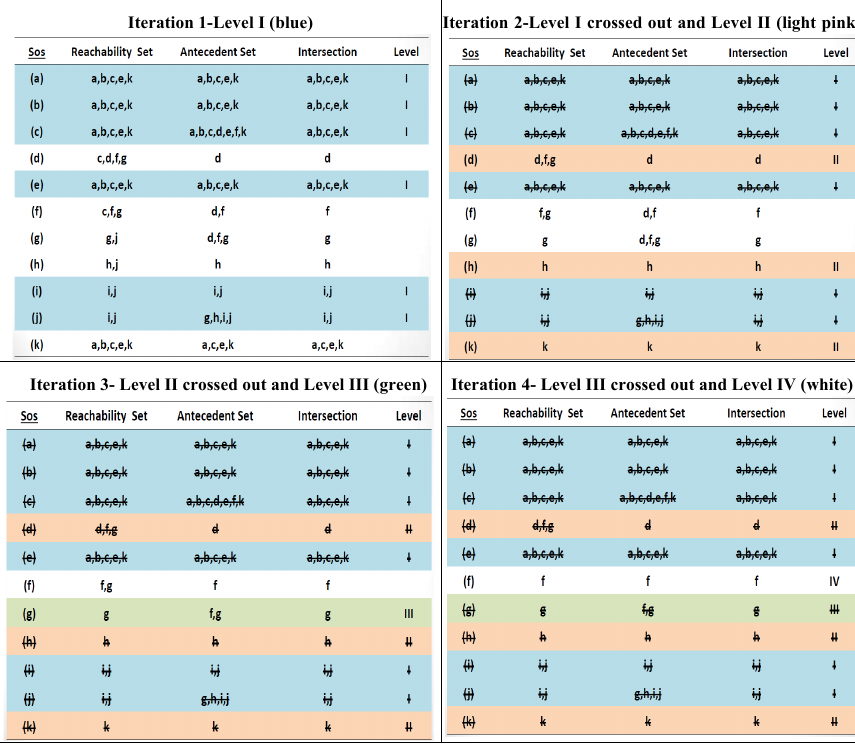
Table 6. Iterations of Labeling in ISM Iteration 1-Level I